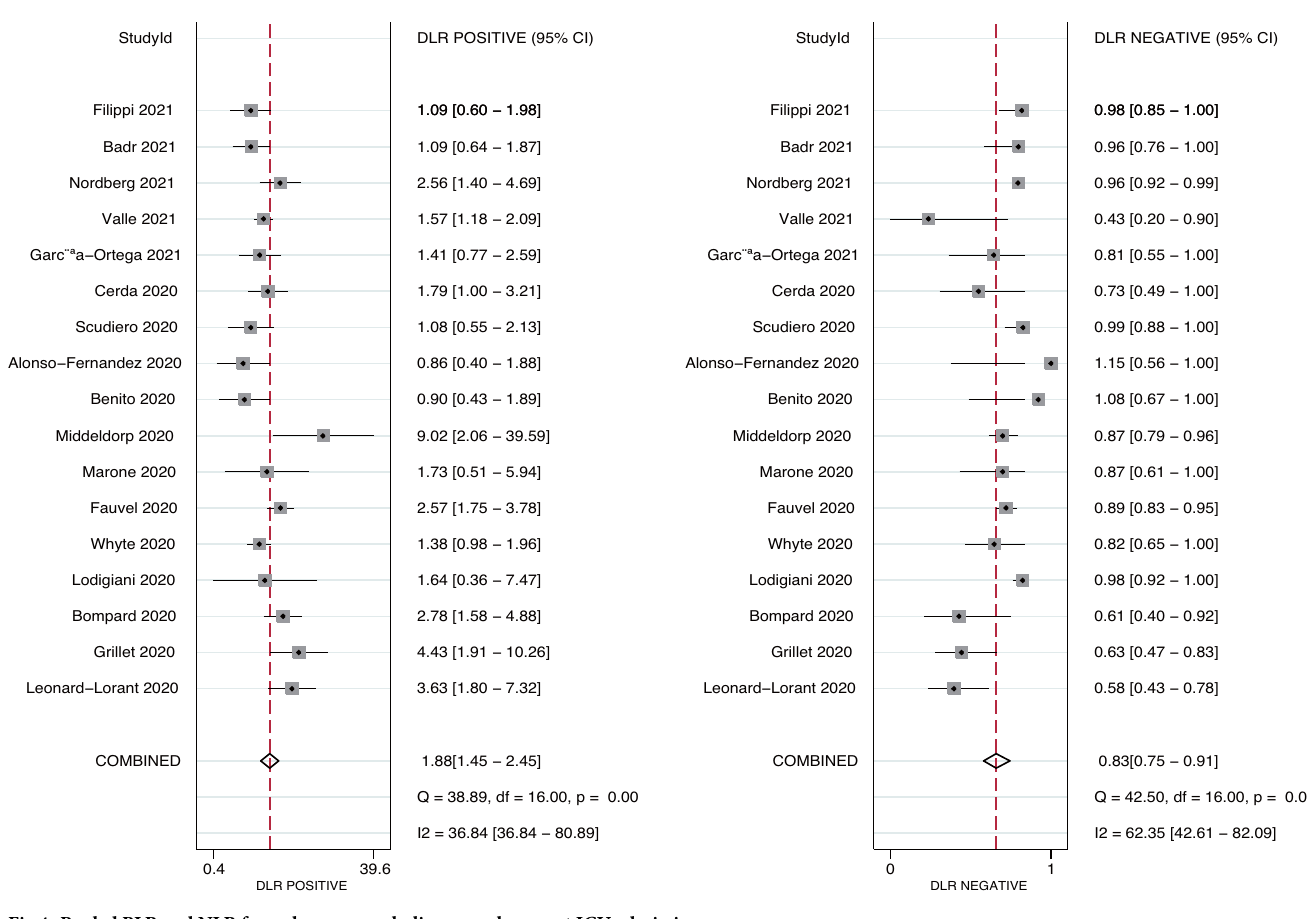
Fig 4. Pooled PLR and NLR for pulmonary embolism on subsequent ICU admission.